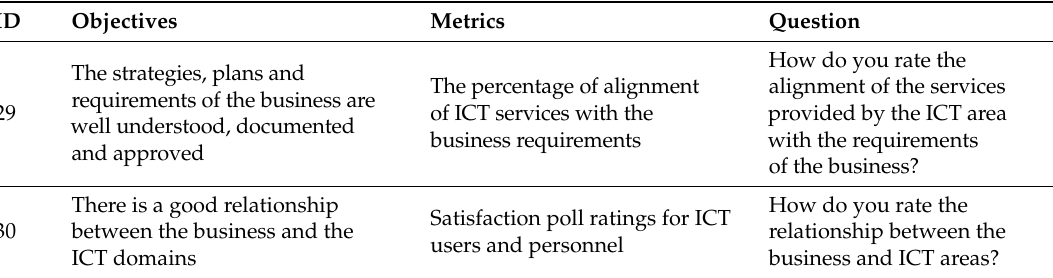
Table 2. Objectives and metrics APO008